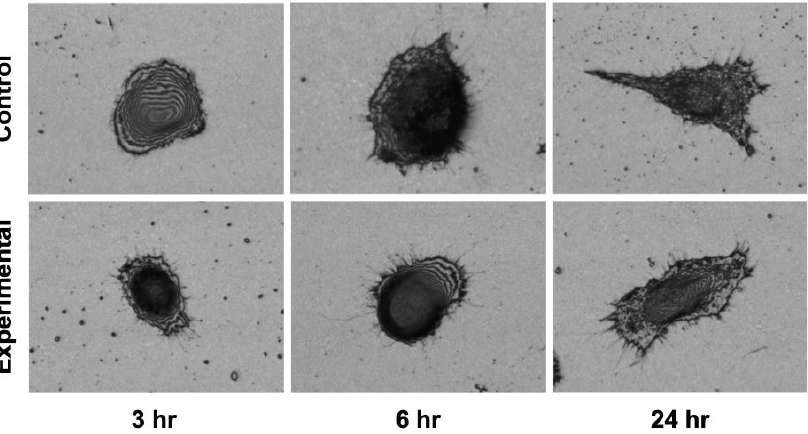
Figure 5. Cell morphology assessed using a 3D measuring laser microscope. The cell morphology showed a trend toward slightly thicker microspike formation and spike elongation in the experimental group compared to the control group.